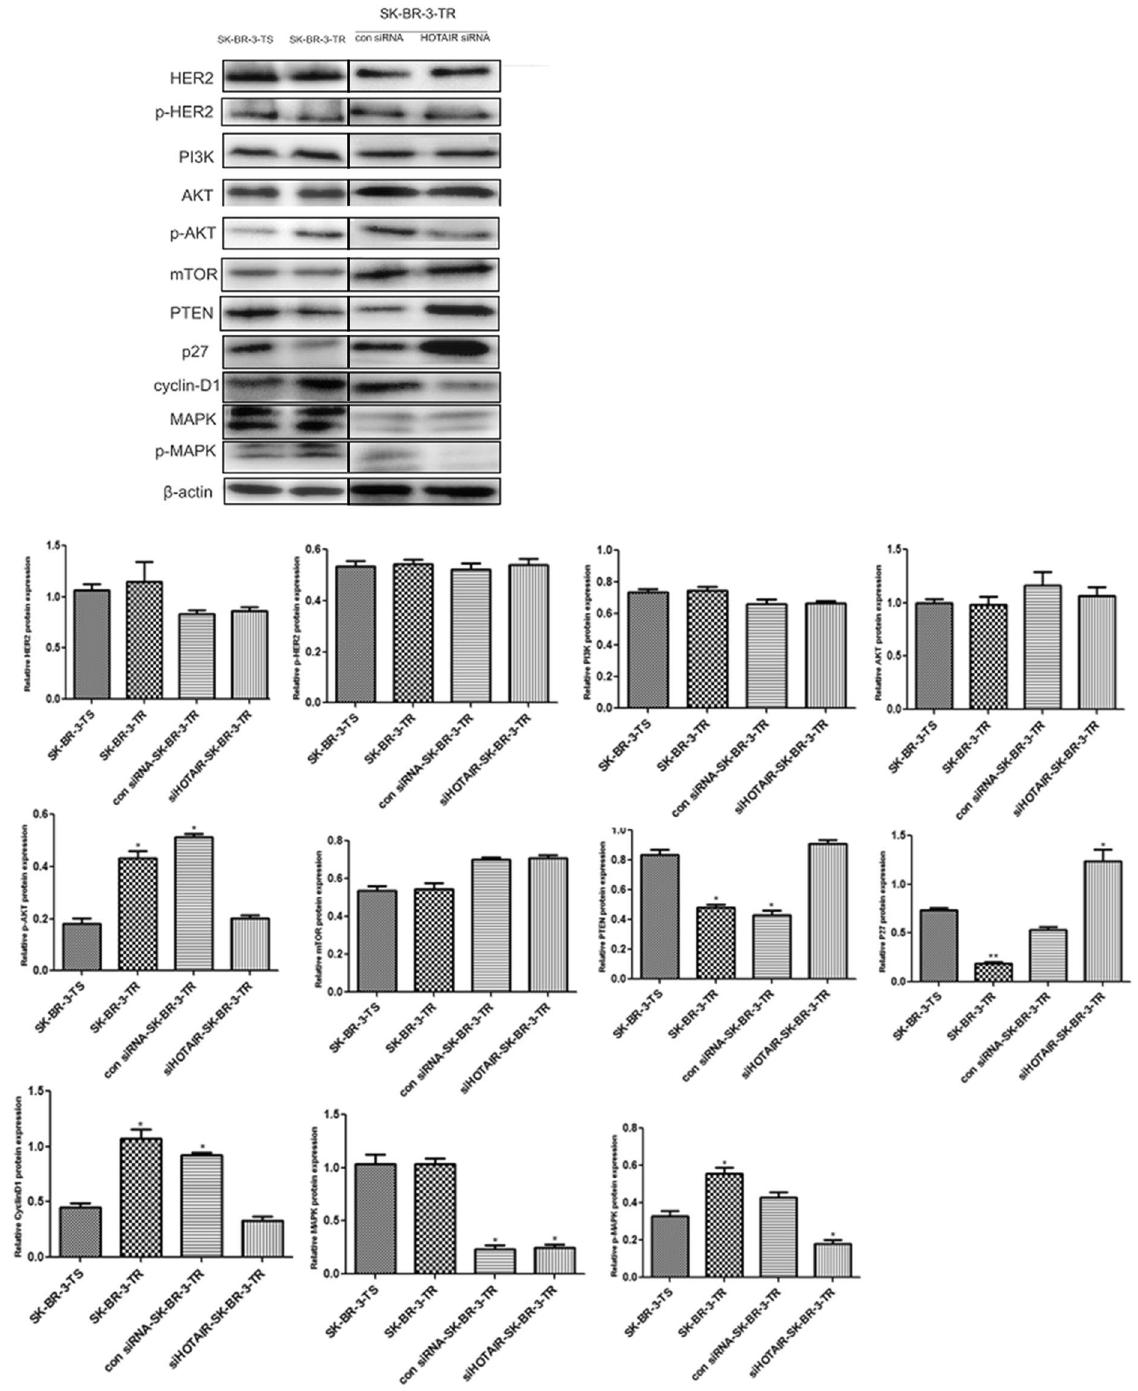
Figure 7. Protein levels of genes in the PI3K/AKT/mTOR, MEK/MAPK and HER2 receptor pathways following SHOTAIR knockdown. Upper panel: representative Western blot, lower panel: protein and phosphorylation levels. ** P < 0.01 vs